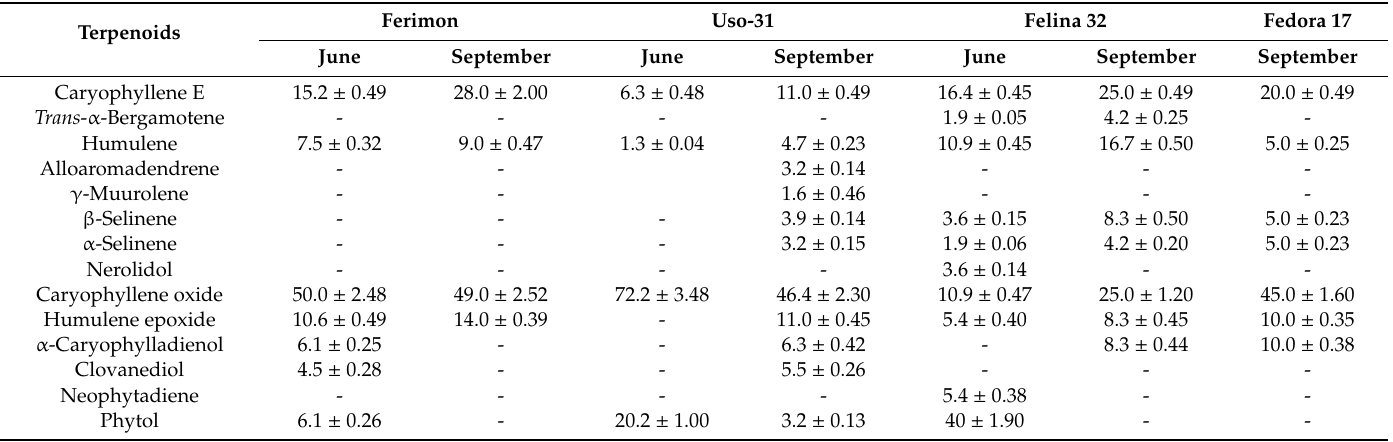
Table 3. GC-MS terpenoids content in Bligh-Dyer organic extracts from inflorescences of Ferimon, Uso-31, Felina 32 and Fedora 17 cultivars harvested in June and September. Results were expressed as [area percentage] mean ± SD (standard deviation), n =